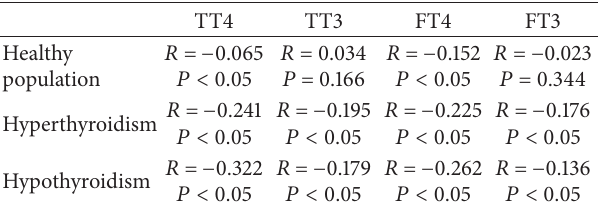
Table 3: Correlation analysis between TT4, TT3, FT4, FT3, and TSH in three groups. TT4 TT3 FT4 FT3 𝑅 = − 0.065 Healthy 𝑃 < population